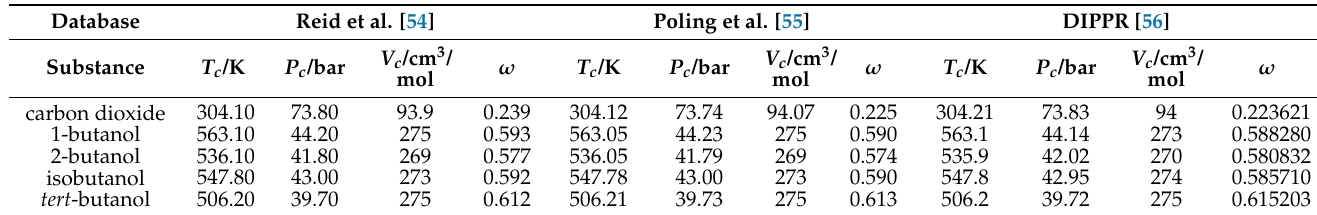
Table 7. Critical parameters ( T c , P c , V c ) and acentric factor ( ω ) for pure components.